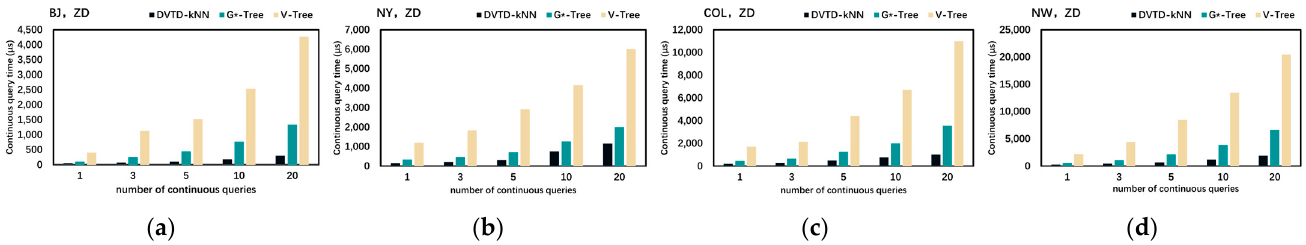
Figure 17. Comparison of query times between baseline algorithms and DVTG-C k NN w.r.t. the number of continuous queries. ( a ) Query times on BJ; ( b ) Query times on NY; ( c ) Query times on COL; ( d ) Query times on NW.